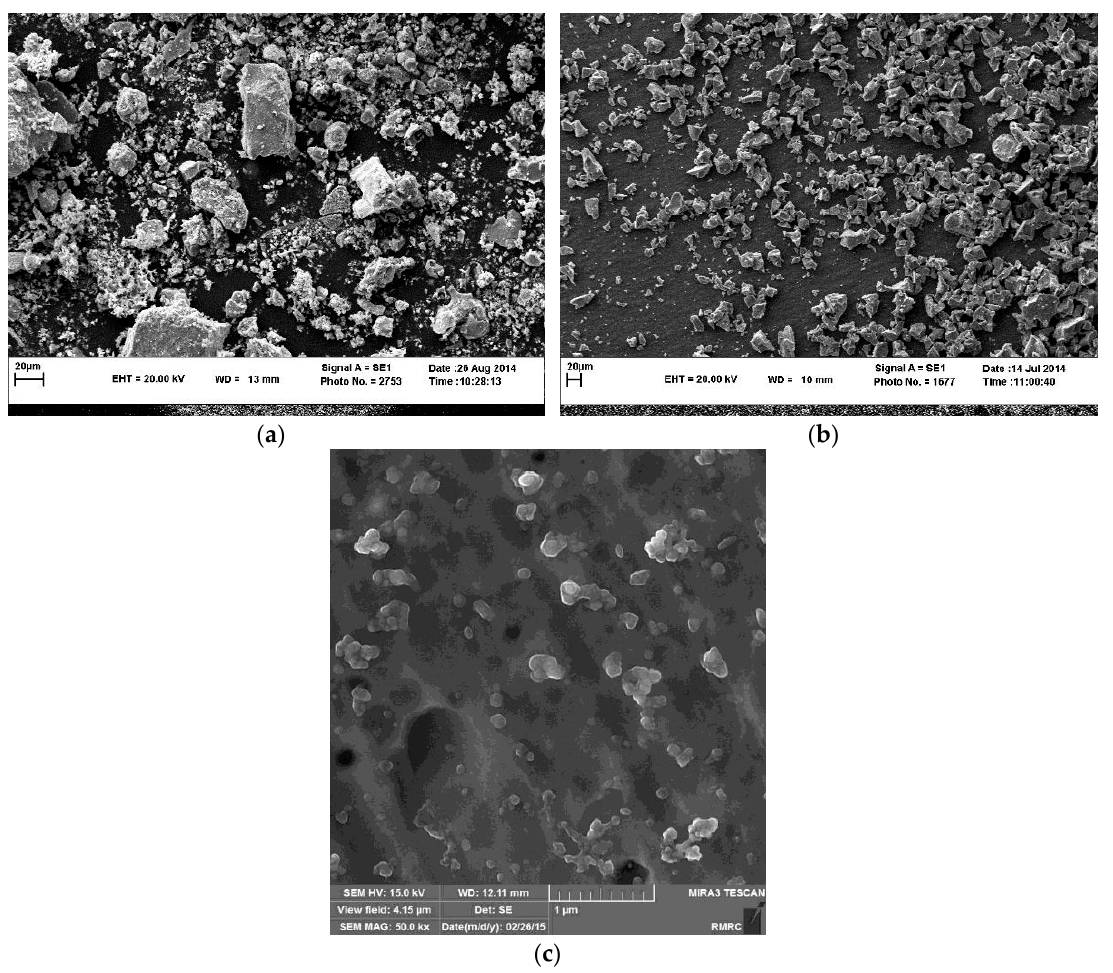
Figure 1. SEM ( Scanning Electron Microscopy) images showing the morphology of the: ( a ) Ti powder; ( b ) TiH 2 powder; and ( c ) SiC nanoparticles.